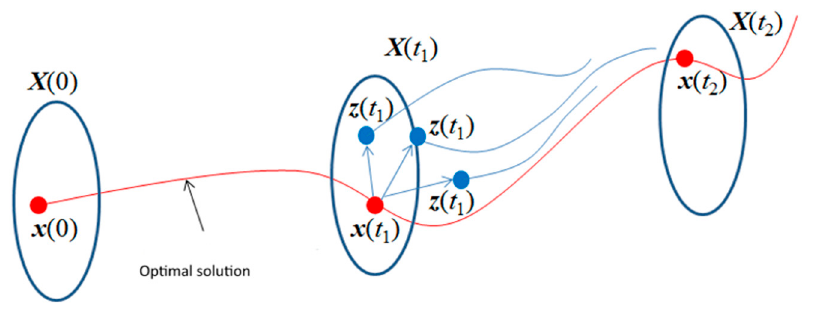
Figure 4. System deflection.